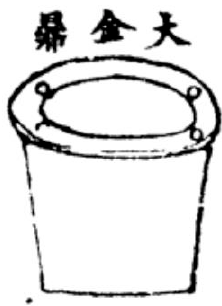
Figure 2. The golden tripod of the heavens (Bai 1988b, p. 165b).